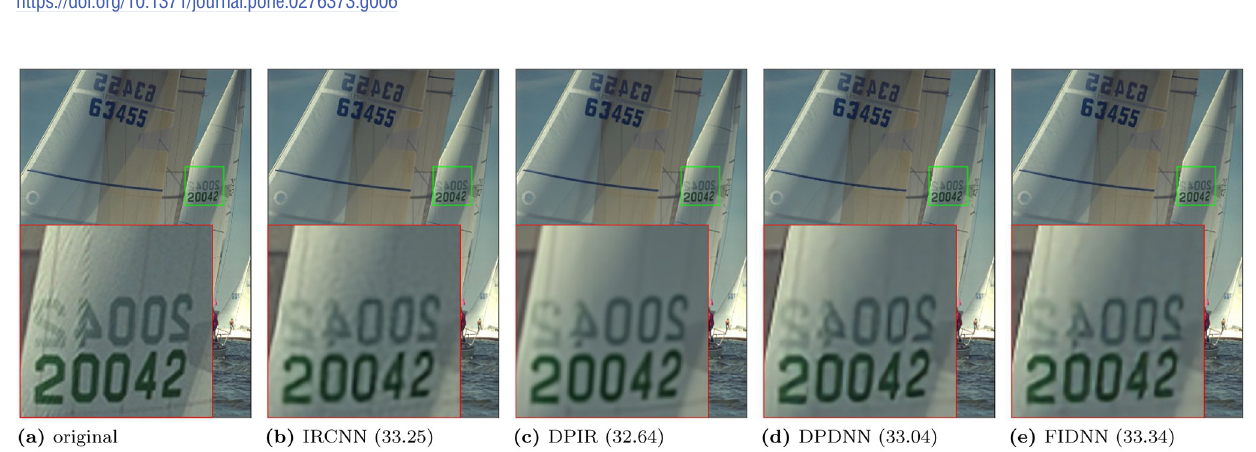
Fig 6. Motion deblurring results for kernel size 17 and noise level 7.65 on ‘Boat’ image from Set10 dataset. (a) original. (b) IRCNN(28.94). (c) IRCNN +(28.78). (d) DPDNN(28.84). (e) FIDNN(29.06).